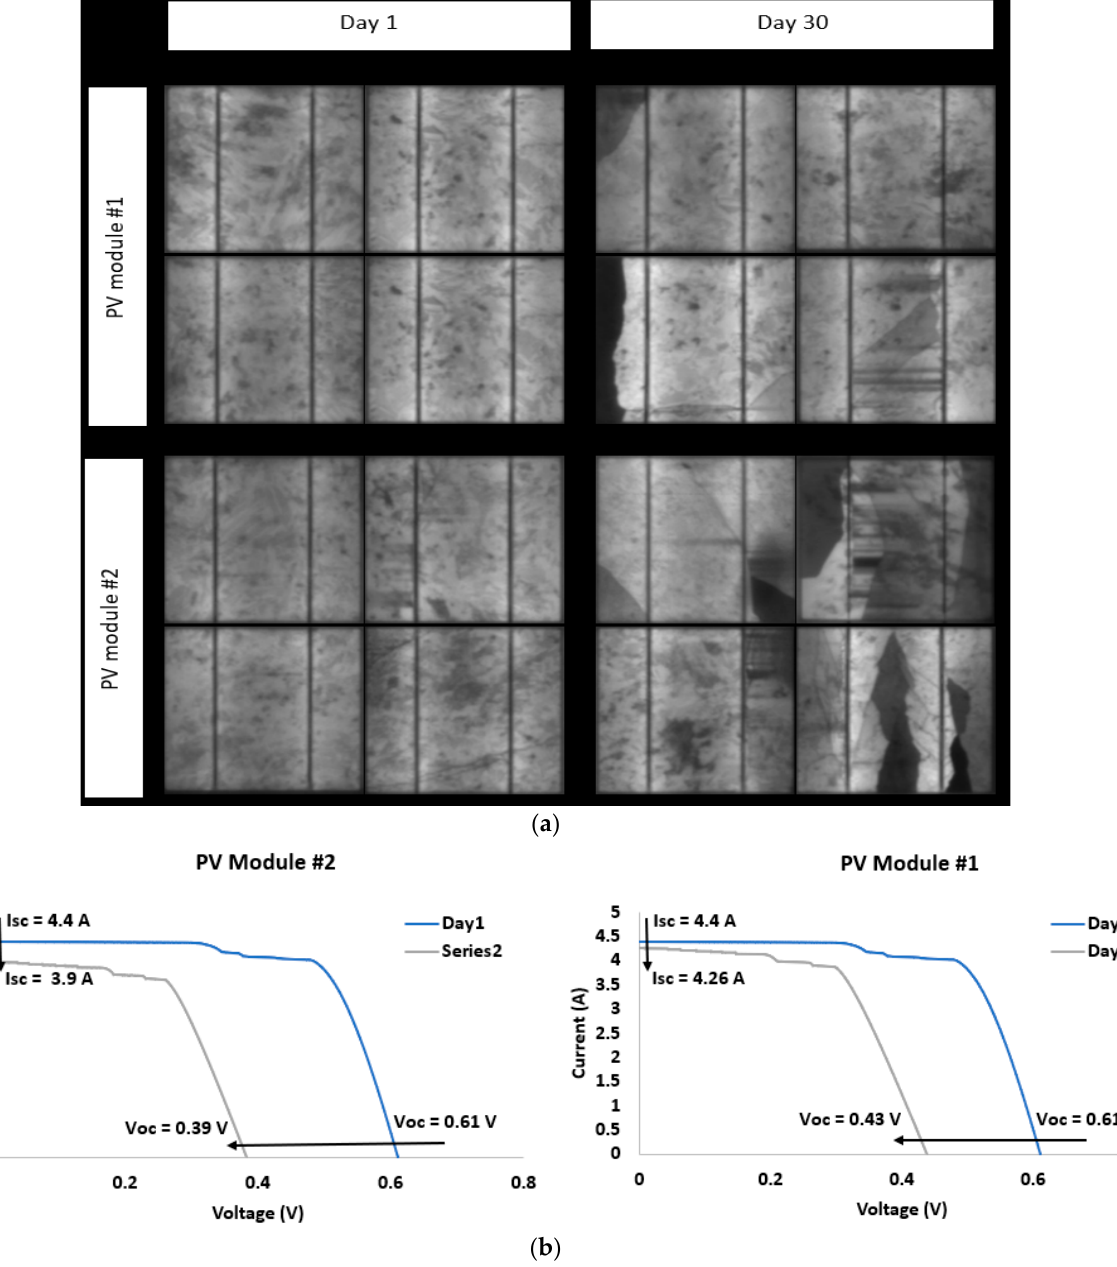
Figure 12. PV solar road: ( a ) Obtained EL images of the solar panels on day 1 and after 30 days of installation. The EL images were taken during night-time at short-circuit conditions, and the irradiance level at 0 W/m 2 and the temperature at 16.3 °C, ( b ) Measured I–V curve for both PV modules.